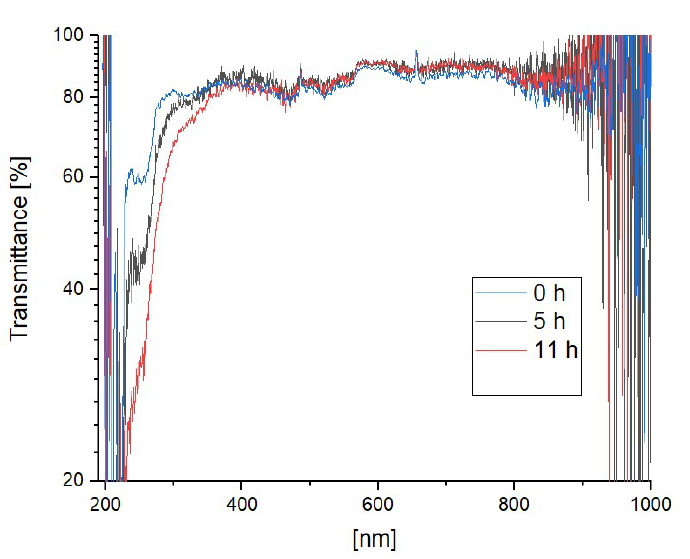
Figure 9. Transmittance of 0.5% (wt) PSAN thin films exposed for different times to UV